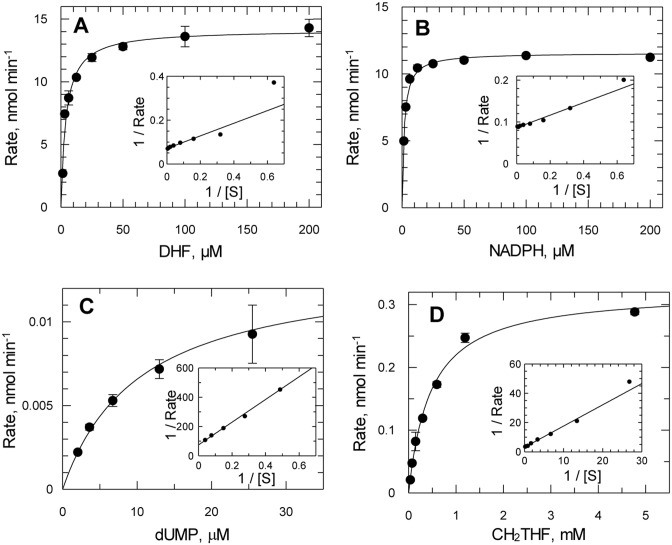
Kinetic constants for recombinant Tsf-TbDHFR-TS.(A) and (B) Determination of DHFR Kmapp values for DHF (4.1 ± 0.6 mM) and NADPH (1.7 ± 0.2 mM), respectively, using purified enzyme. (C) and (D) Determination of TS Kmapp values for dUMP (8.2 ± 0.6 mM) and CH2THF (470 ± 50 mM), respectively, using clarified E. coli lysates. Assays were performed as described in methods. Values represent weighted means of three independent determinations. One representative determination is shown for each Kmapp.